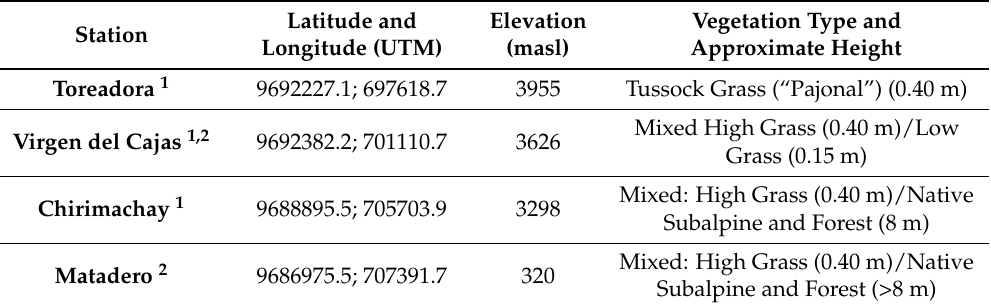
Table 1. Location of weather and stream flow-gage stations and typical vegetation cover in the surrounding area.